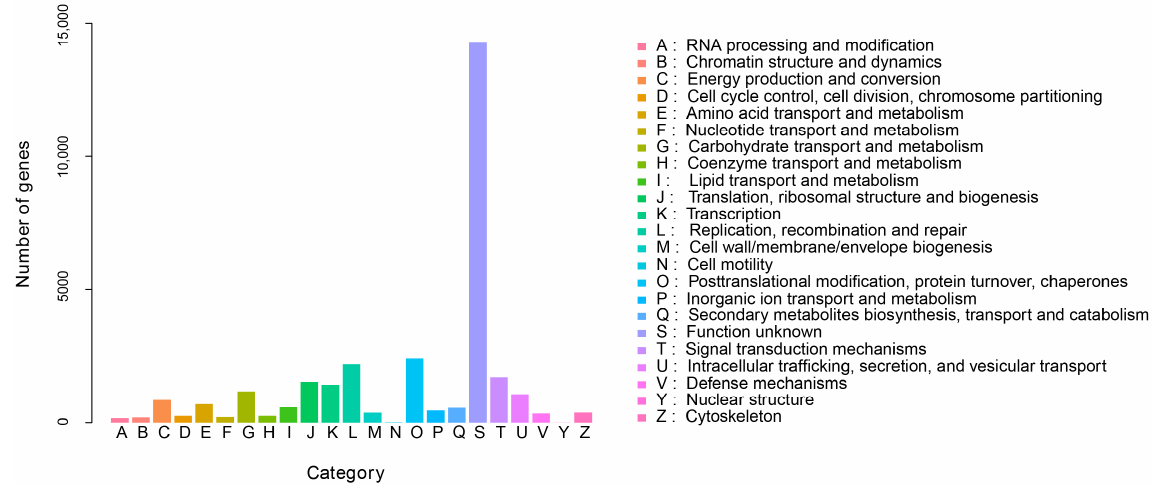
Figure 3. The eggNOG annotation of G. macrophylla transcriptomic unigenes.